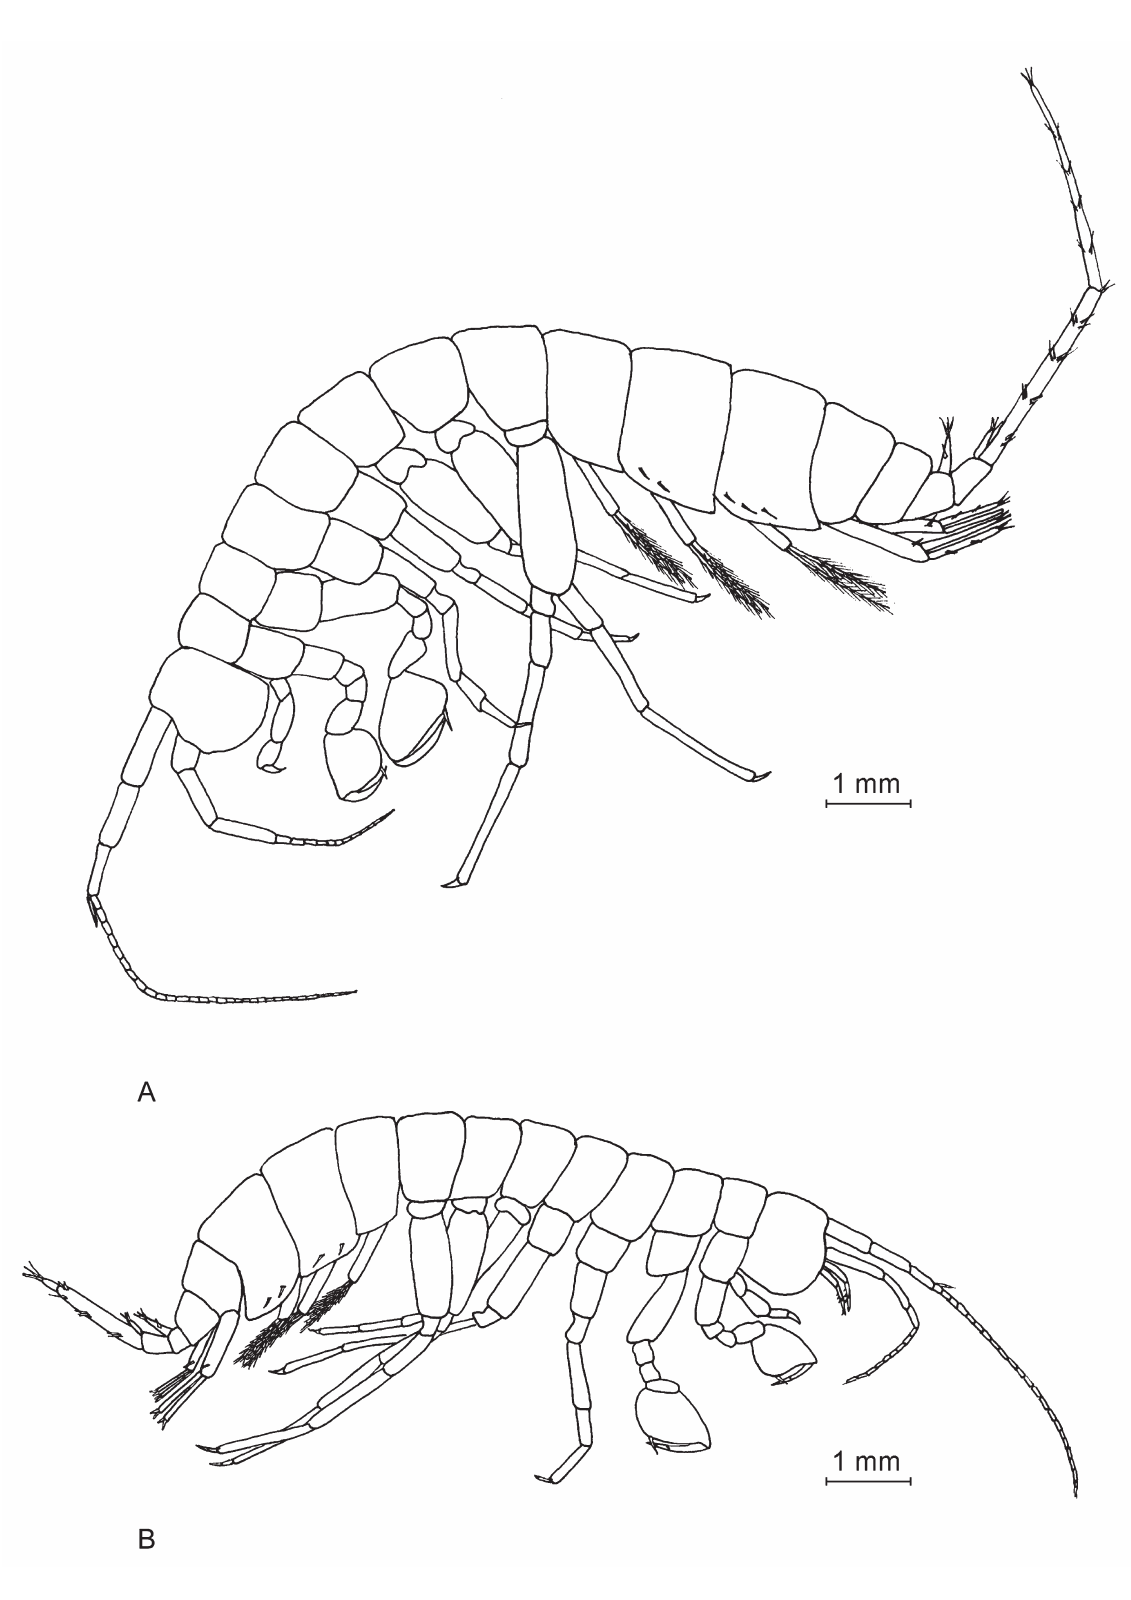
Fig. 2. General appearance of Niphargus dancaui sp. nov. A . ♂. B .